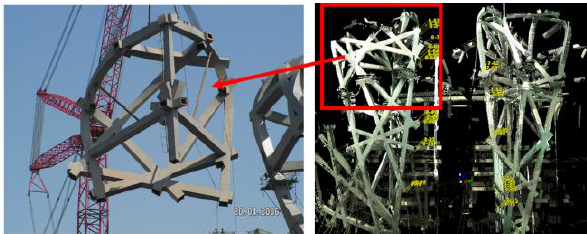
Figure 7 install field and point cloud of installed colomns